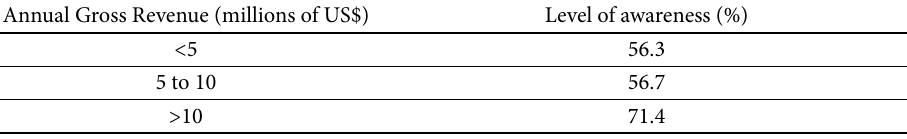
table 2. level of awareness on environmental sustainability of construction companies according to company size